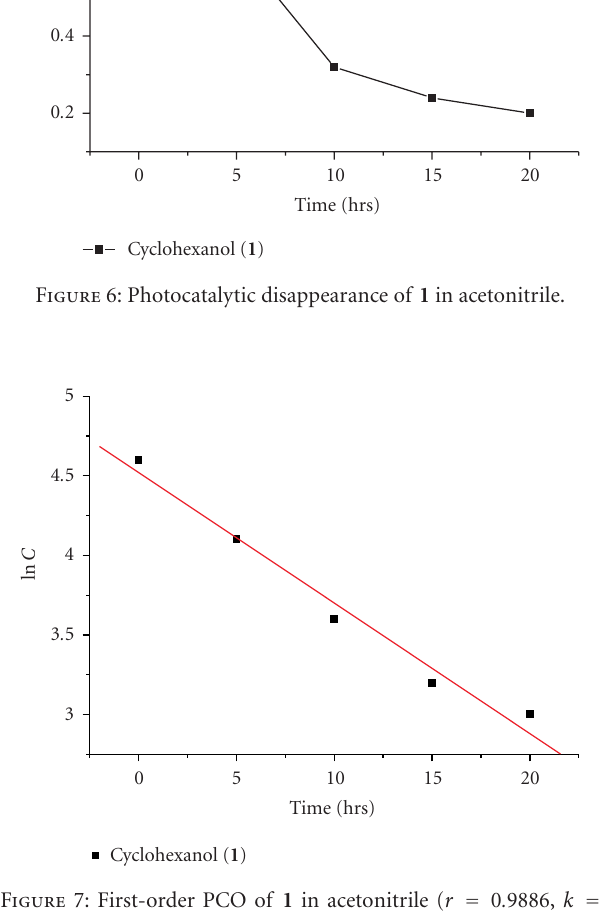
Figure 7: First-order PCO of 1 in acetonitrile ( r = 0 . 9886, k = − 0 . 083 hr − 1